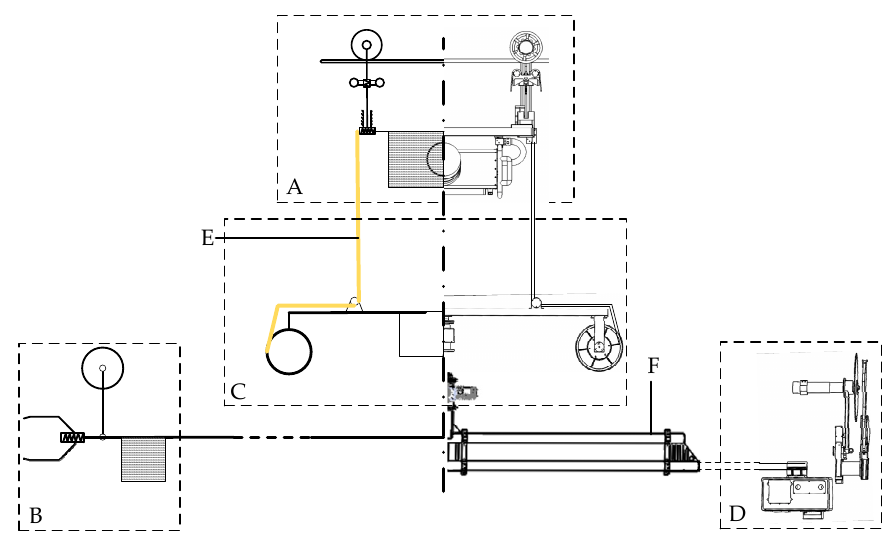
Figure 2. A typical coverage graph of a BTR.